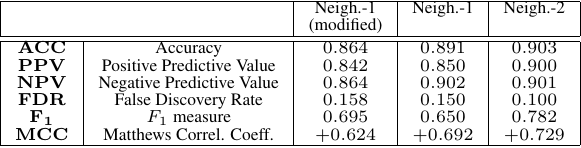
Table 2: Change Detection